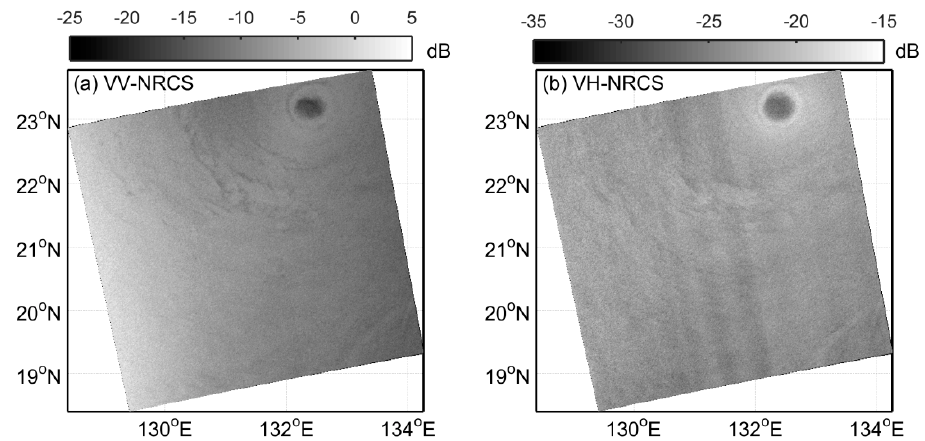
Figure 2. Dual-polarized RADARSAT-2 ScanSAR images over Typhoon Lan (09:20 UTC, 21 October 2017): ( a ) VV-polarization and ( b ) VH-polarization. RADARSAT-2 Data and Products MacDonald, Dettwiler, and Associates Ltd. (Toronto, ON, Canada), All Rights Reserved.